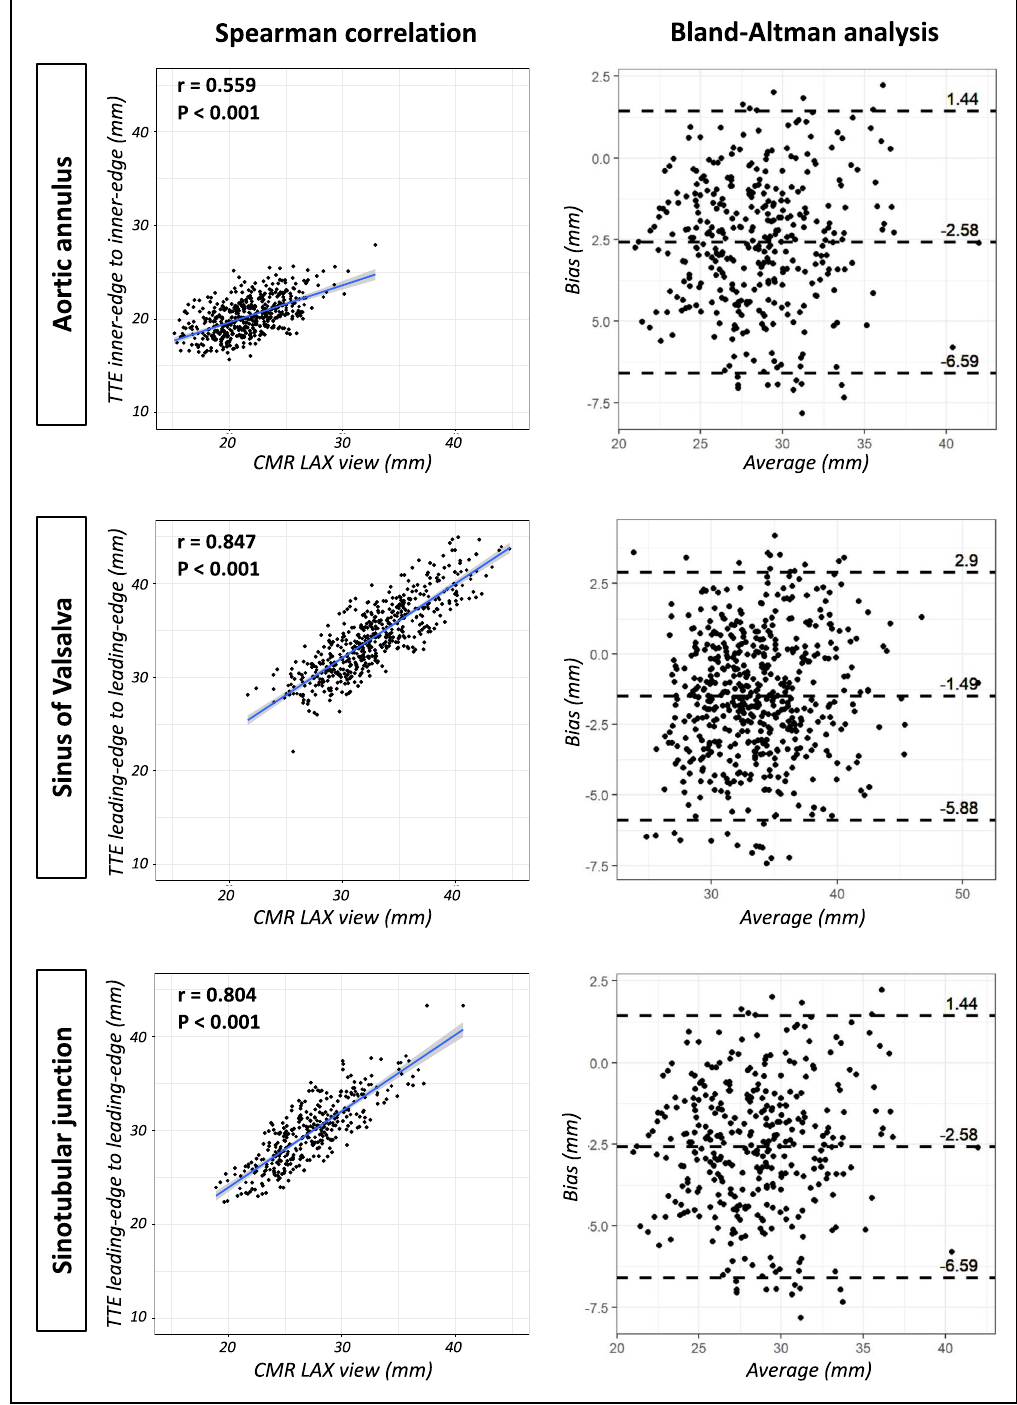
Figure 3. Comparison of TTE and CMR measurements of the aortic root. The following scatter plots show the linear regression line for two values as well as the spearman correlation coefficient and p-value. The Bland– Altman plots show the mean bias between the two values (CMR measurements subtracted by the corresponding TTE measurement) and the 95% confidence interval. CMR cardiac magnetic resonance imaging, LAX long-axis view, TTE transthoracic